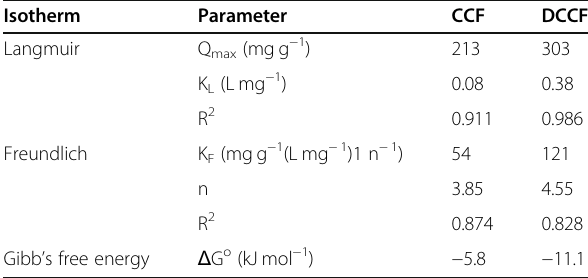
Table 3 Langmuir and Freundlich constant value results from linear fitting and free energy values for CCF and DCCF Isotherm Parameter CCF